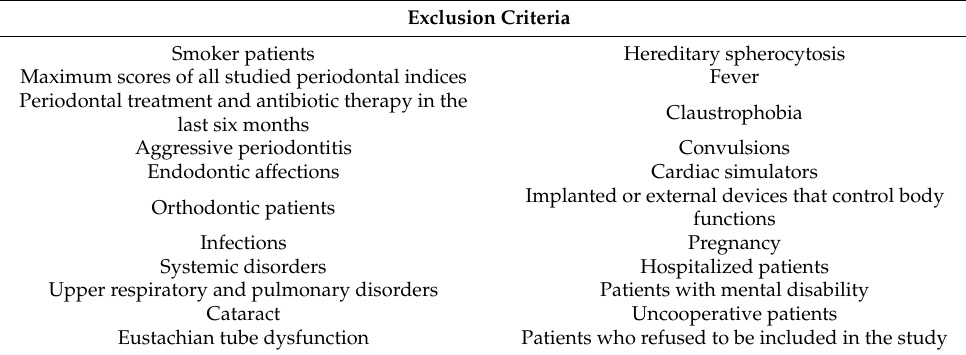
Table 3. Exclusion criteria of patients in